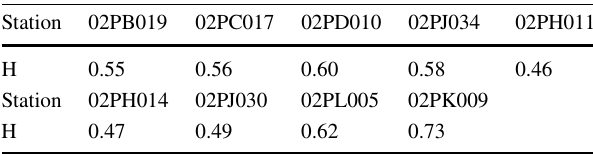
Table 2 Results of P -value for the Hurst coefficient (H) of runoff data